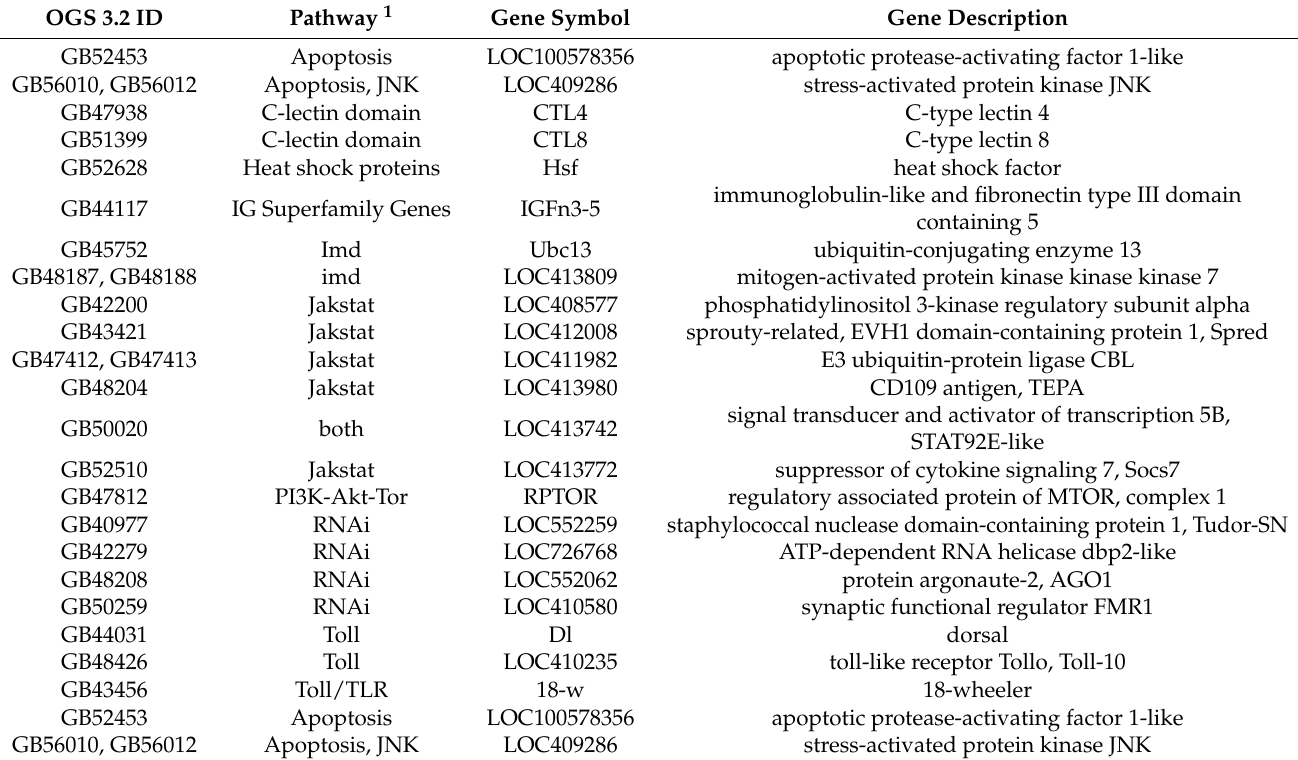
Table 4. Selected downregulated immunity genes identified by both DESeq2 and edgeR. OGS 3.2